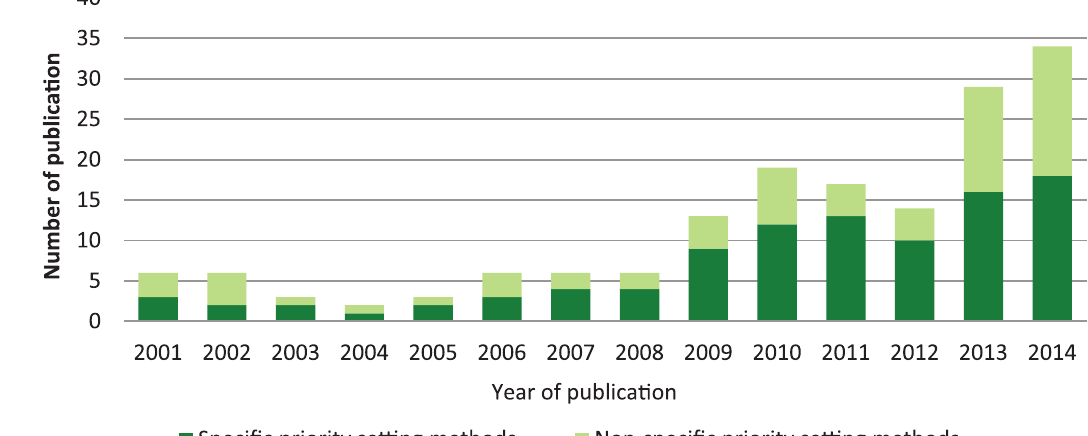
Figure 2. Total number of publication by year (source: PubMed, 2001 to 2014).